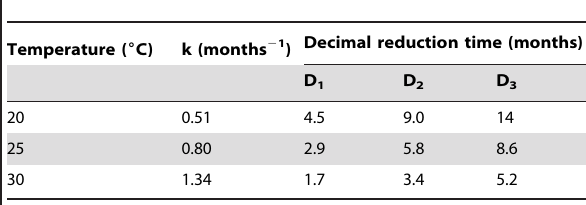
Table 3. Kinetic parameters of the laboratory powders.